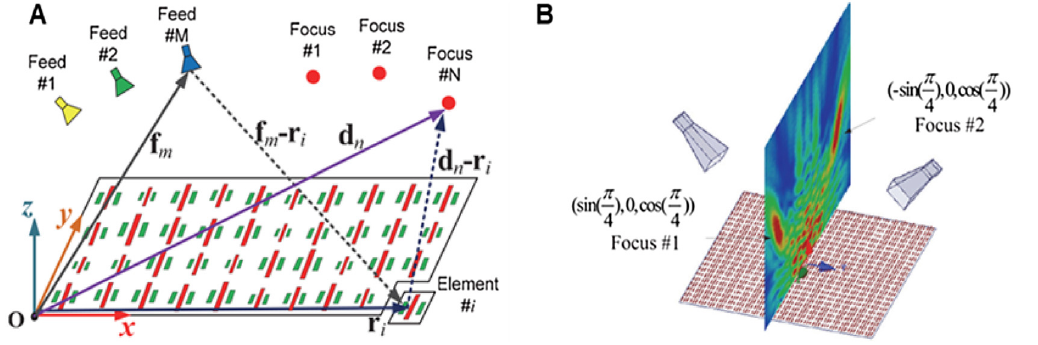
Figure 6: NFF metasurface. (A) The reflective metasurface for the multi-feed and multi-focus WPT system. (B) Full-wave simulation of the reflective metasurface [73]. Reprinted from [73], with the permission of IEEE